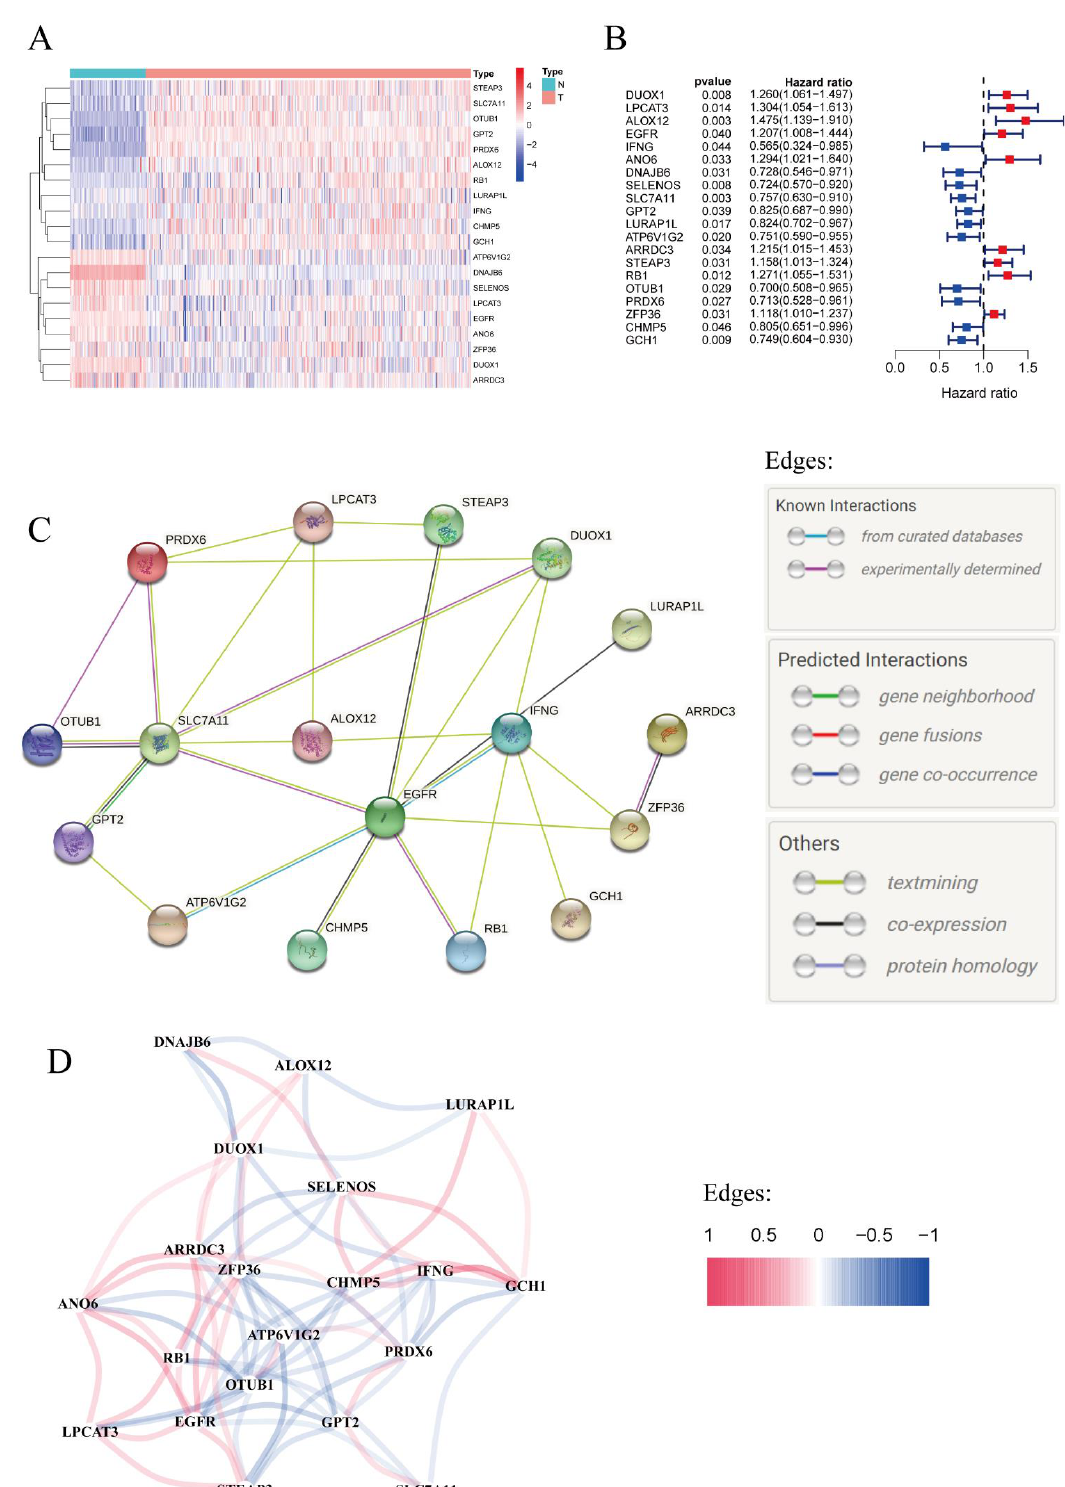
Figure 2. Identification of prognostic ferroptosis-related genes in OC. ( A ) Heatmap reflecting ex- pression levels of prognostic ferroptosis-related genes. Type: N, normal tissues; T, tumor tissues. ( B ) Forest plot of prognostic ferroptosis-related genes. ( C ) PPI network, downloaded from the STRING database, that indicates known interactions and possible interactions among the candidate genes. ( D ) Correlation network between intersectional